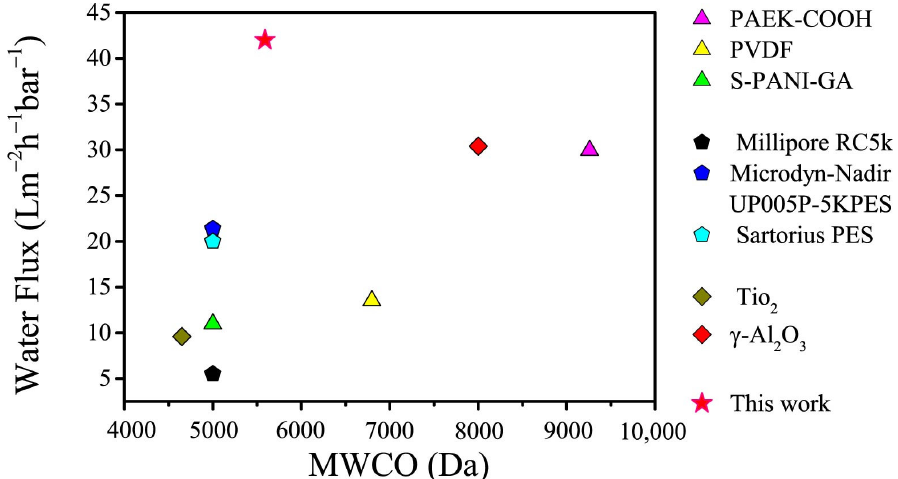
Figure 13. The TUF membranes with similar MWCO are listed. Water flux of non-commercial